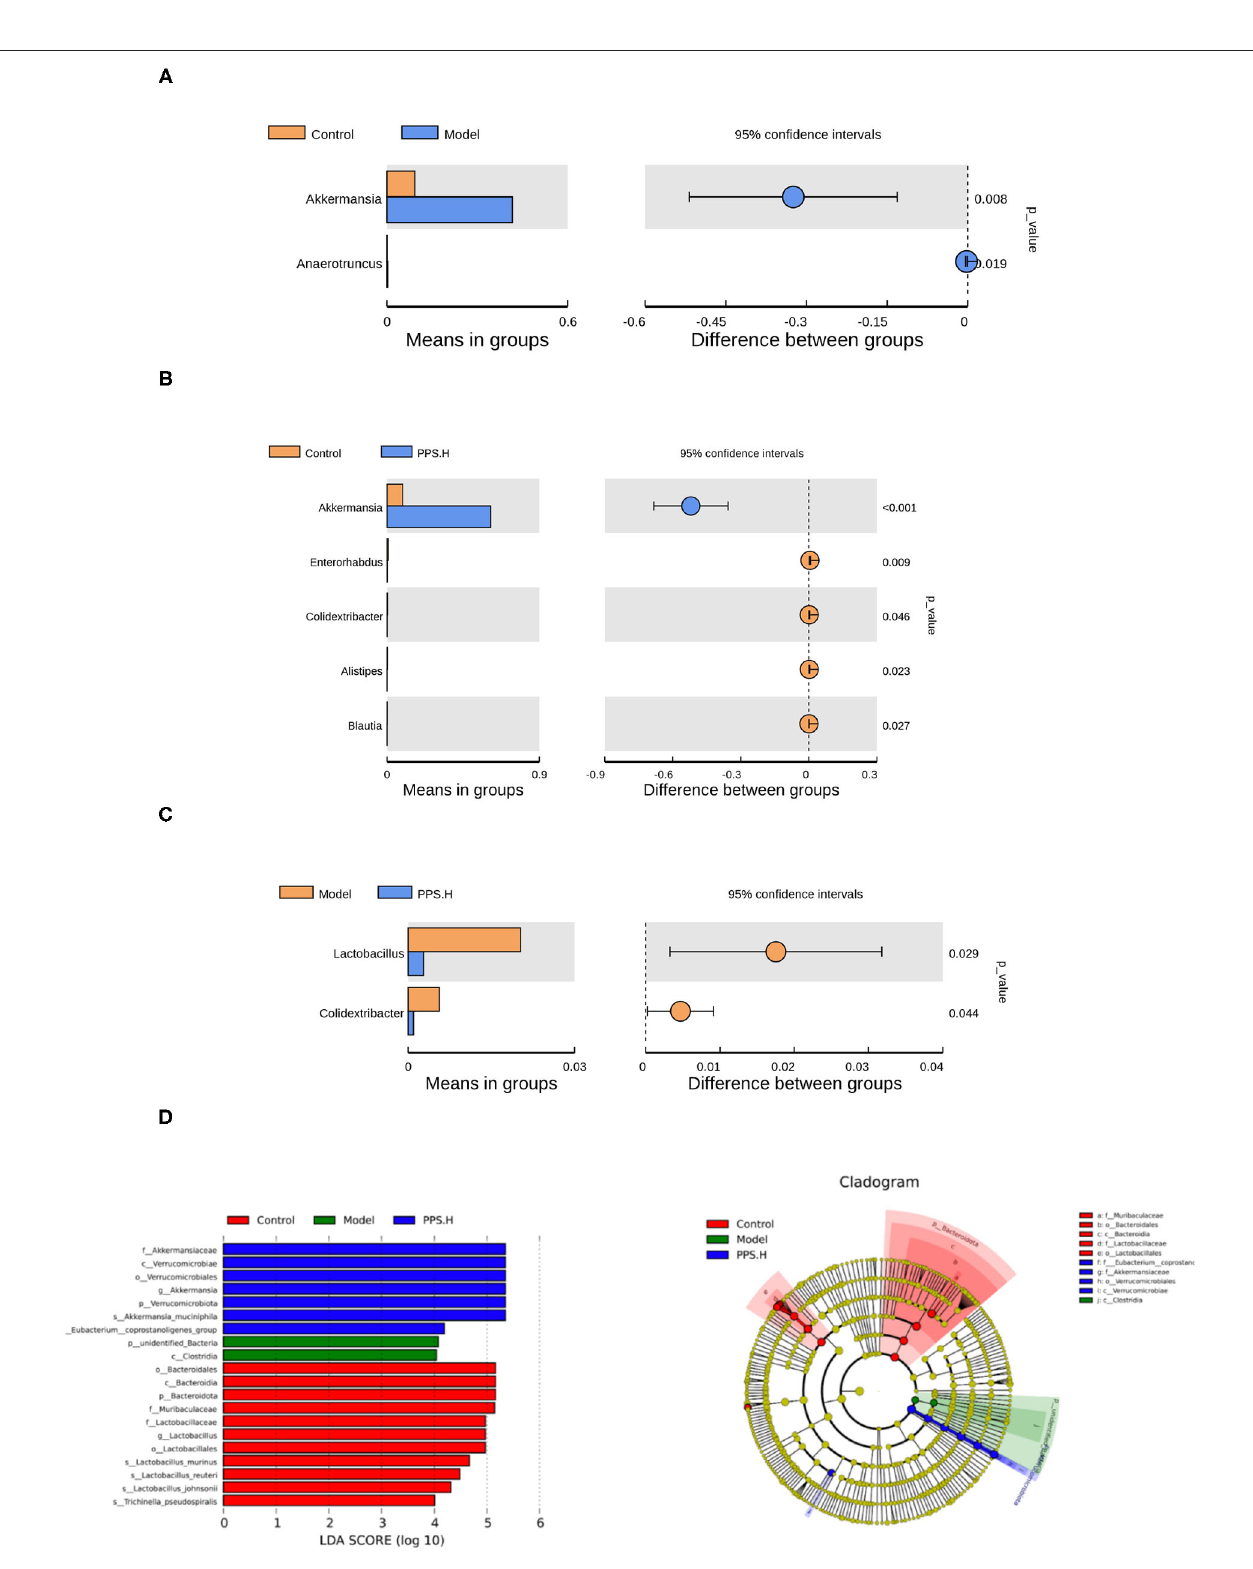
FIGURE 10 | Species differences between t -test groups of control and model. (A) Control and PPS.H. (B) Model and PPS.H. (C) At genus level. (D) Linear discriminant analysis (LDA) and LDA of effect size (LEFSe) of different groups of microbial flora. The maximum difference between groups after LDA uses a threshold score >